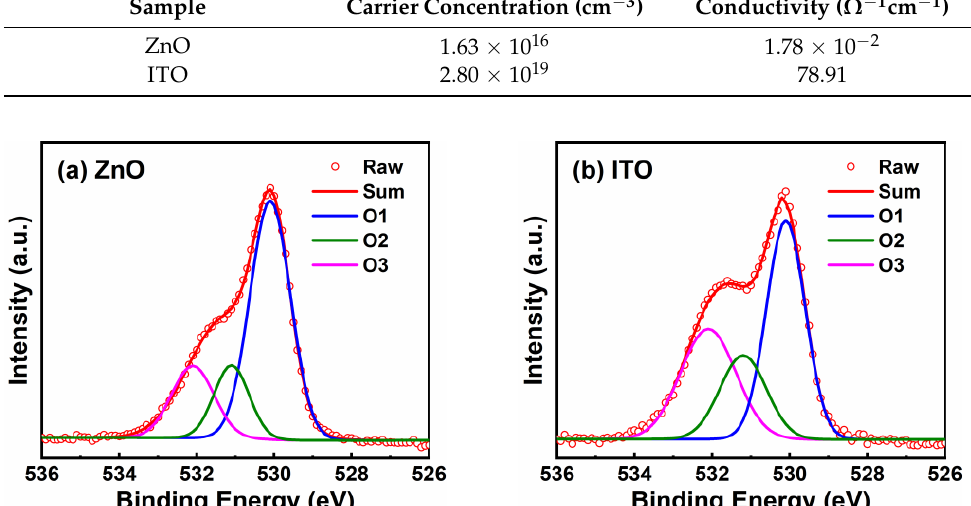
Figure 3. XPS spectra of ( a ) ZnO and ( b ) ITO films. ZnO and ITO films were deposited on Si substrates.